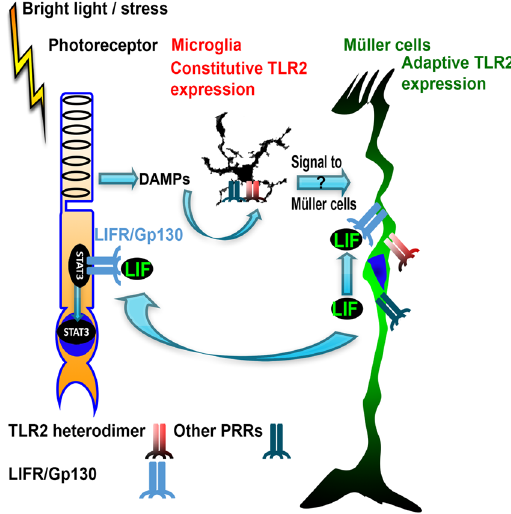
Figure 5. Proposed model of stress-induced LIF expression. This model is constructed from our data and previous data published in the literature from our lab and others. Stress, either from acute light damage or inherited mutation, induces the formation of DAMPs, which signal to TLR2 and other receptors on microglia. Microglia then produce an intermediate signal to induce Müller cell stress responses, including LIF expression to protect photoreceptors and slow degeneration. In addition, Müller cells upregulate TLR2 and other PRRs allowing them to directly respond to